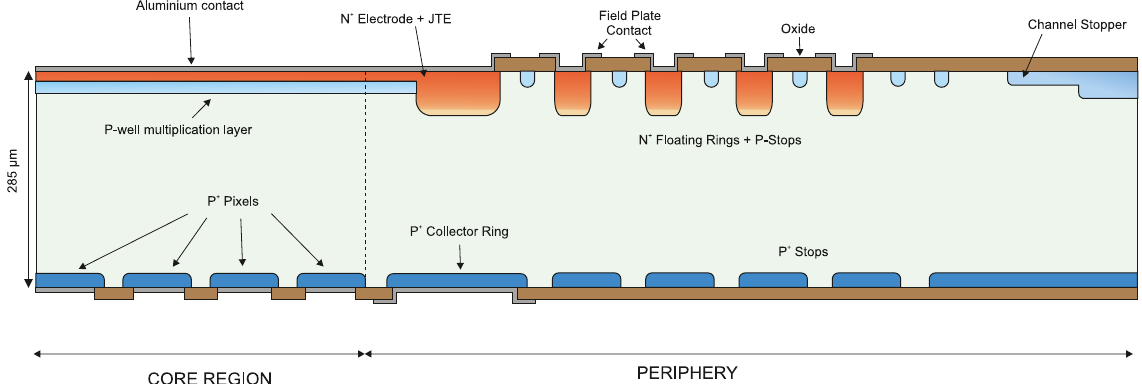
Figure 7. Schematic cross-section of the final periphery design including four n-type floating rings and p-stops at the multiplication side. At the ohmic side, we added four high-doped p-stops and a field plate at the collector ring, to move the high electric field peak towards the